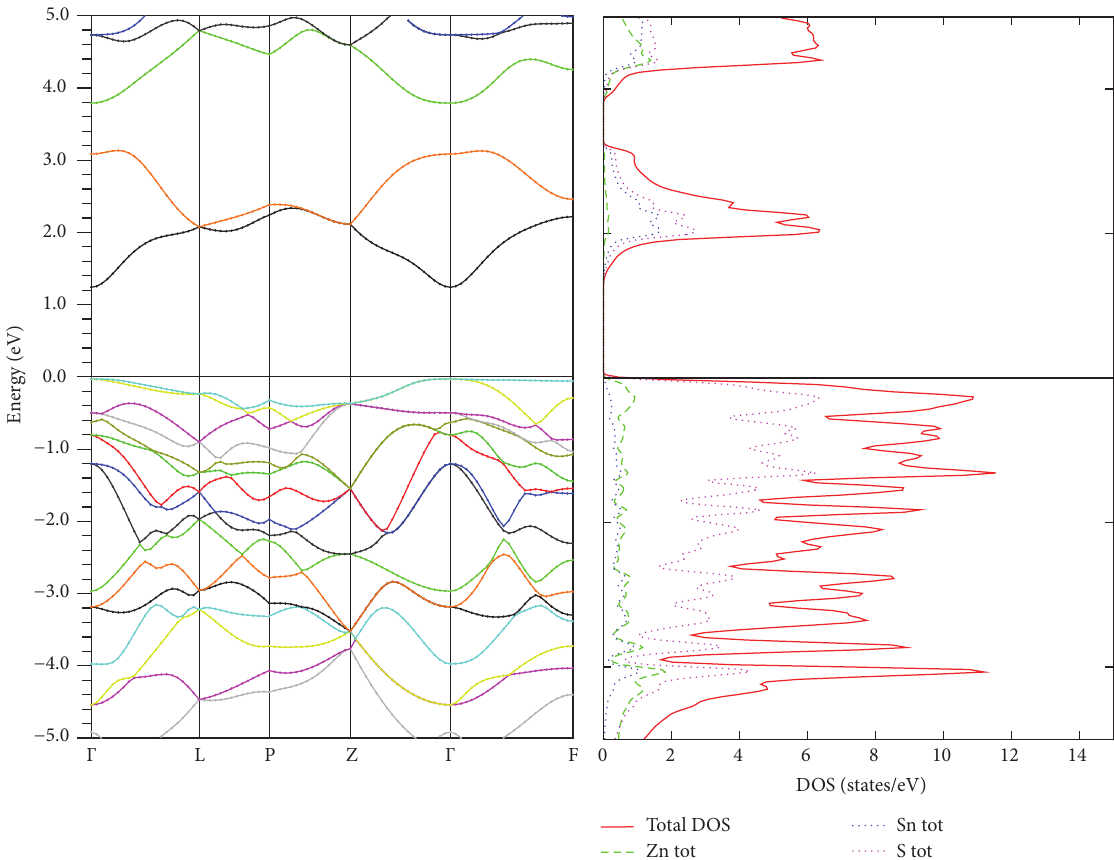
Figure 2: Energy bands in the LN-phase (space group 161) of ZnSnS 3 , plotted along high symmetry directions, along with a plot of the density of states. The bands are calculated by using the mBJ potential for exchange and correlation. The zero of energy is taken to coincide with the valence band maximum.